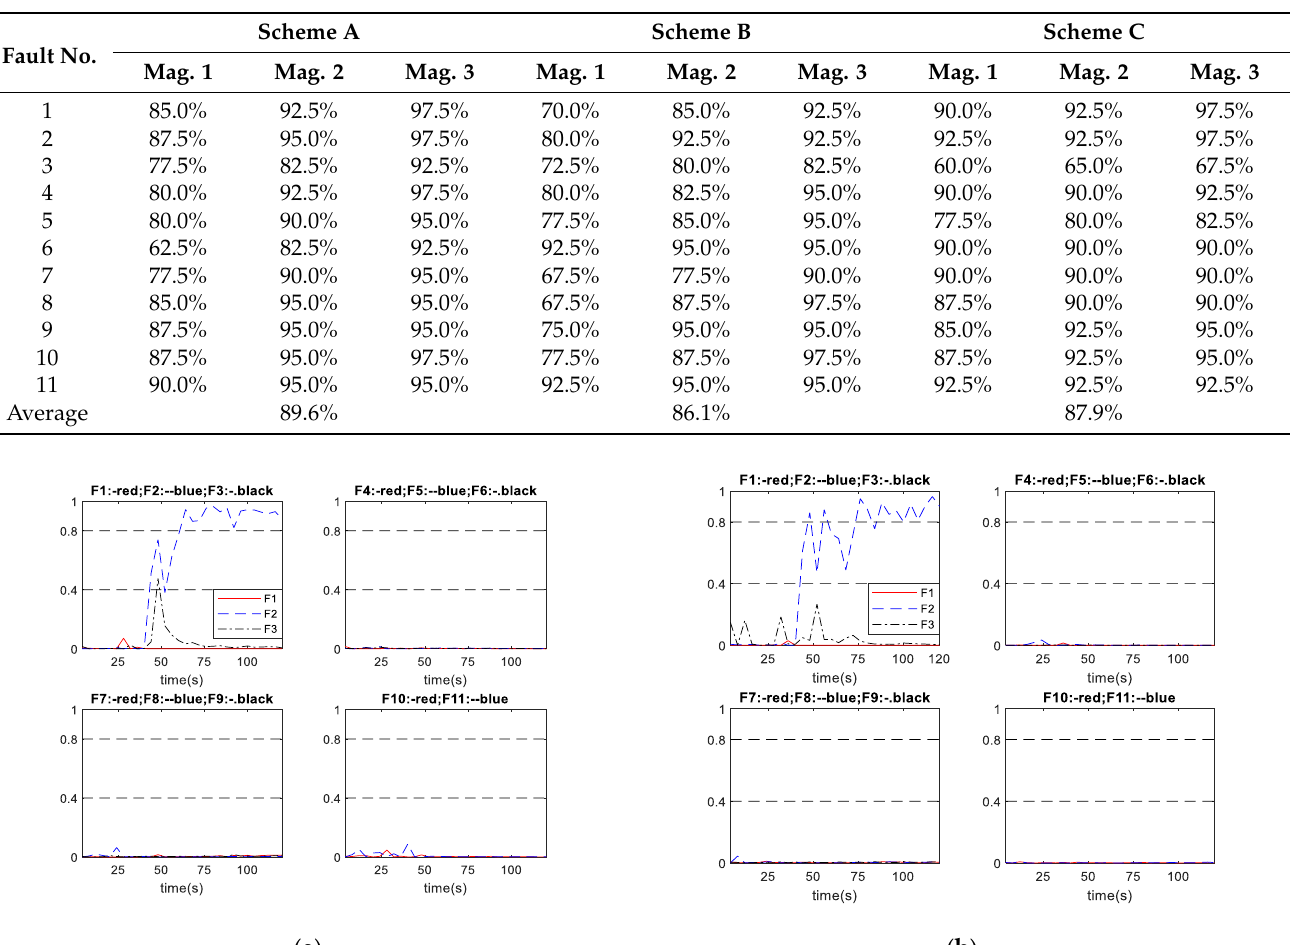
Table 11. Fault detection rates for abrupt faults.